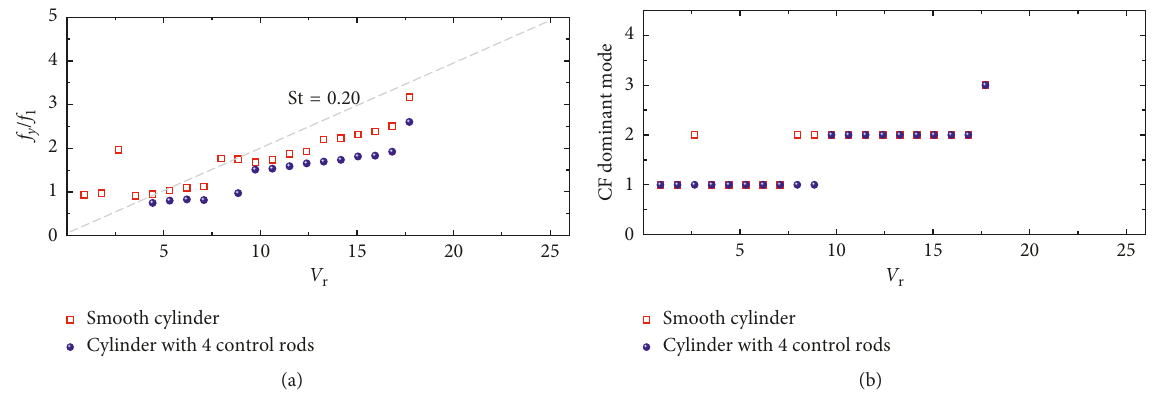
Figure 13: Dominant frequencies (a) and dominant modes (b) of the main inclined flexible cylinder with control rods versus the reduced